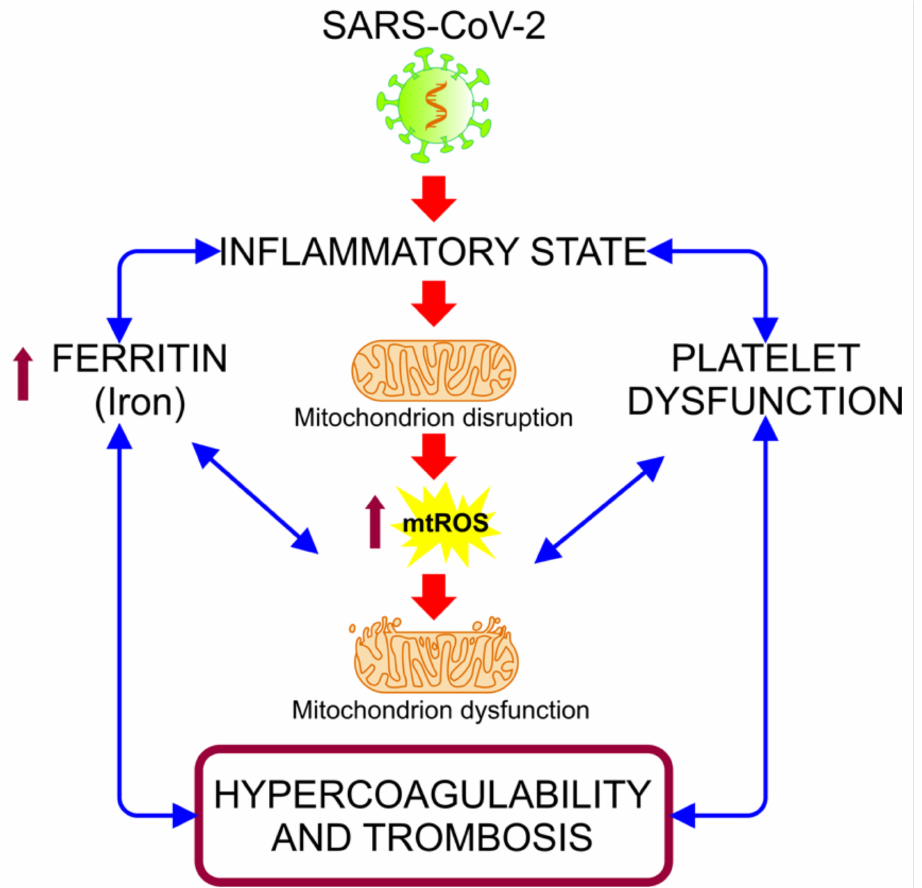
Figure 1. Alteration of iron homeostasis and states of hypercoagulability and thrombosis caused by the hyper-inflammatory state associated with COVID-19. The relationship between the inflammation caused by SARS-CoV-2 infection and the increased ferritin and platelet dysfunction generates a vicious cycle, in which the mitochondrial dysfunction intensifies, inducing an increase of the mito- chondrial reactive oxygen species (mt-ROS) and causing an exacerbation of this cycle, resulting in a state of hypercoagulability and thrombosis